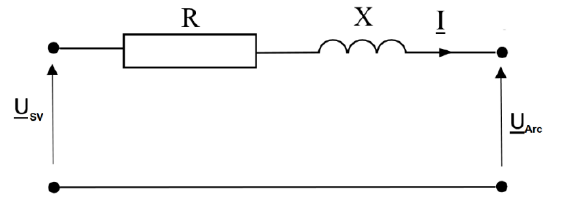
Figure 3. Single-phase equivalent diagram of the arc furnace taking into account the resistance of the arc-supplying circuit.